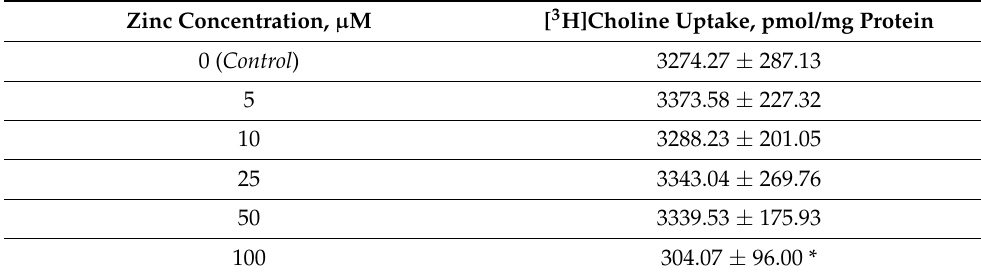
Table 3. Thirty-minute apical uptake of 10 µ M [ 3 H]choline in choroid plexus epithelial cells (CPECs) after 24 h pre-treatment with 5–100 µ M ZnCl 2 in serum-free medium (SFM). Zinc Concentration, µ